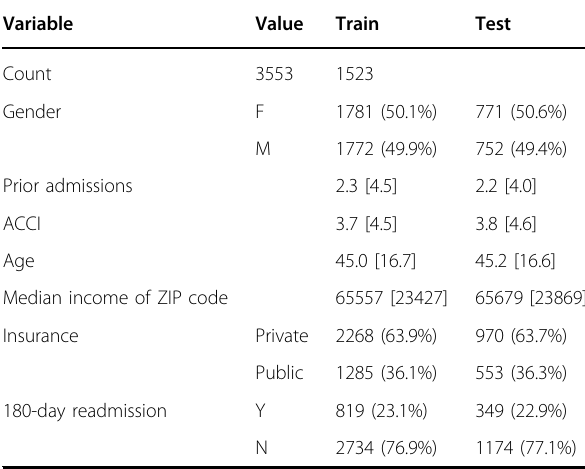
Table 1 Population